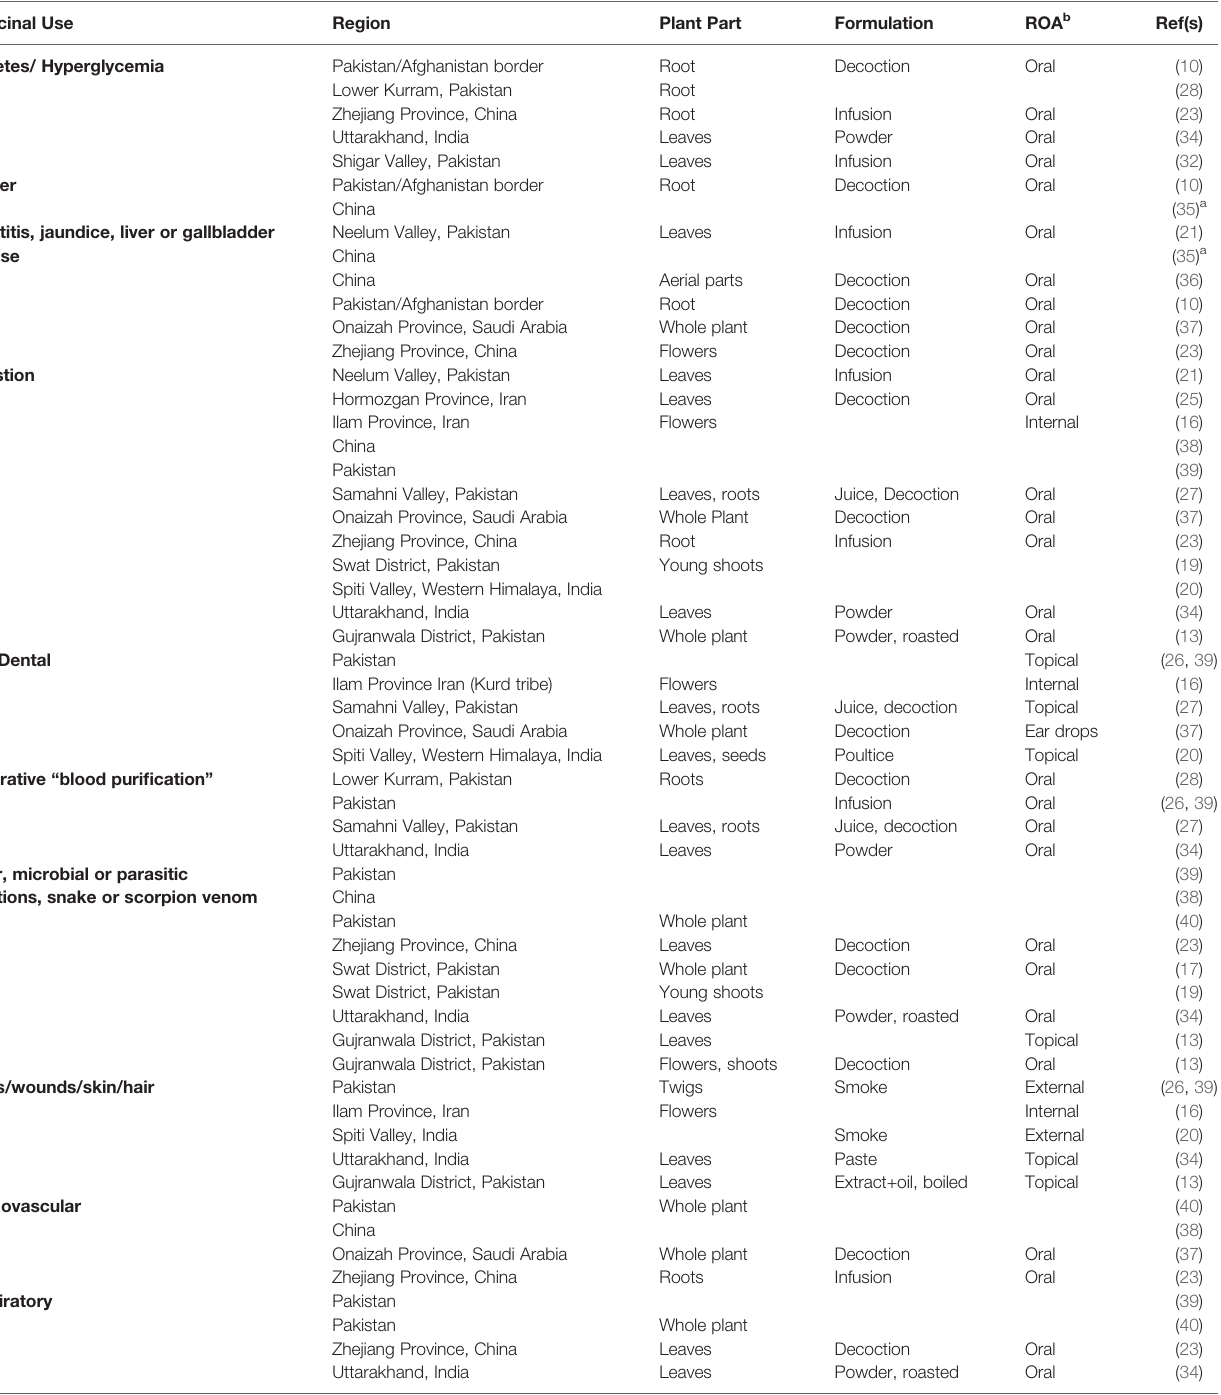
TABLE 1 | Documented indications and geographic locations for traditional uses of A. scoparia